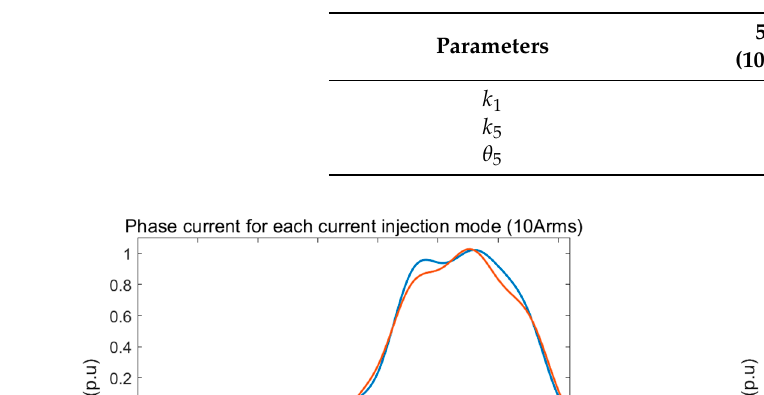
Figure 15. Torque curves at 480 r/min and 5 Arms for fundamental-controlled operation. Table 5. Optimized experimental harmonics coefficient.